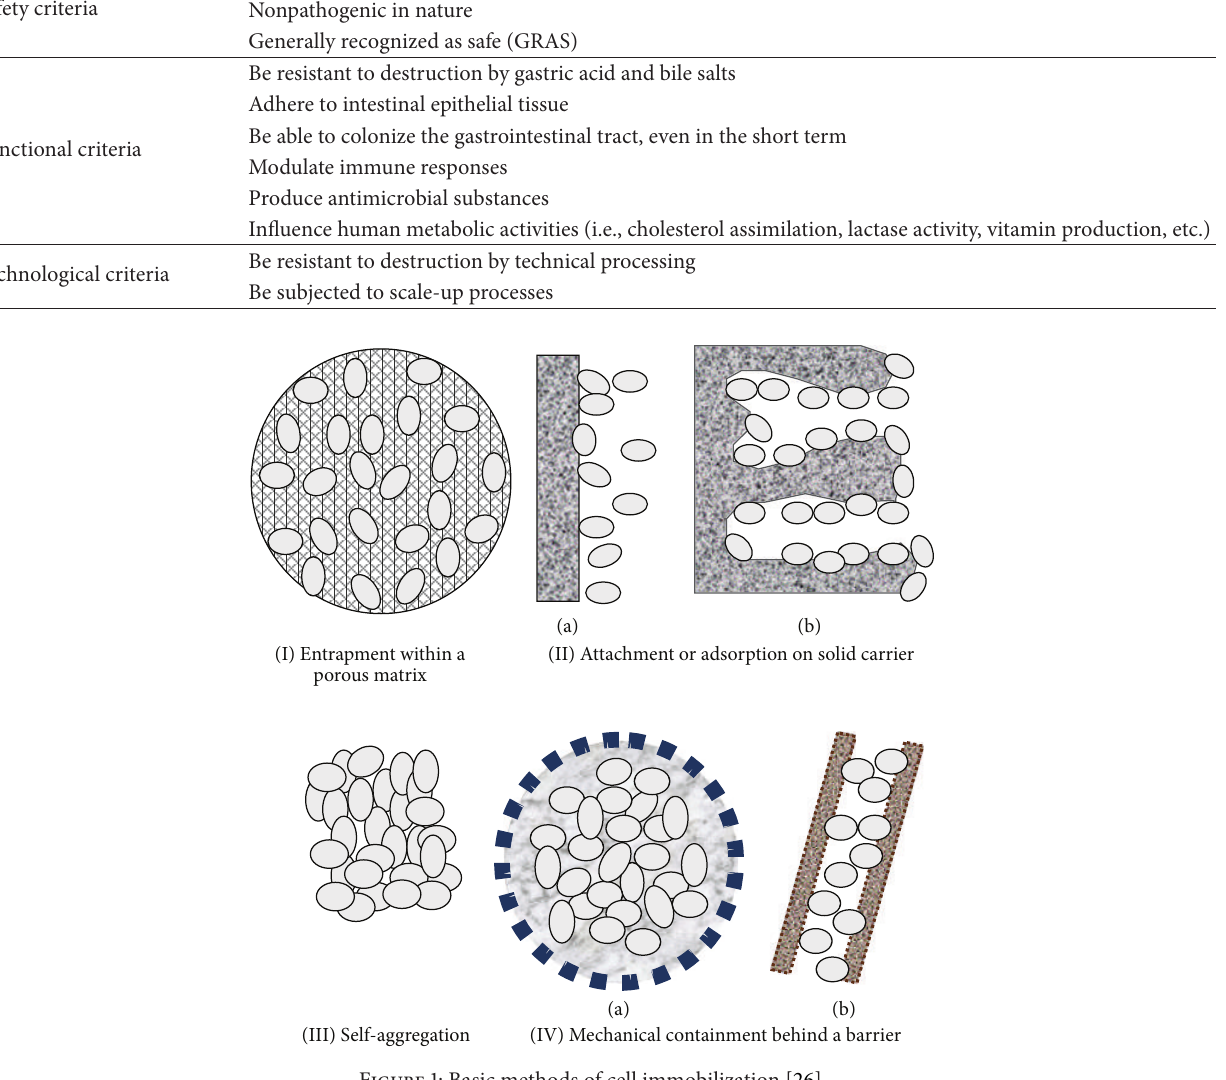
Figure 1: Basic methods of cell immobilization